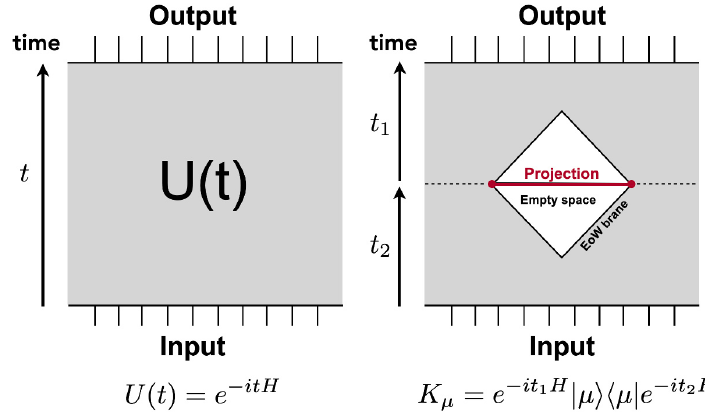
Figure 6 . Quantum circuits with (right)/without (left) a projective